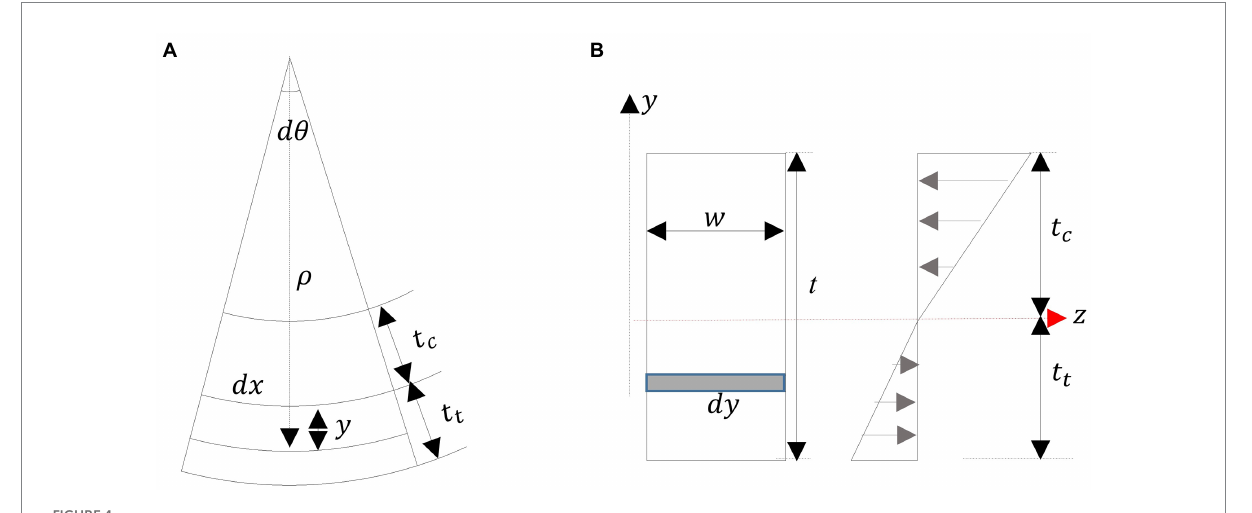
FIGURE 4 Bending force of rock slab.